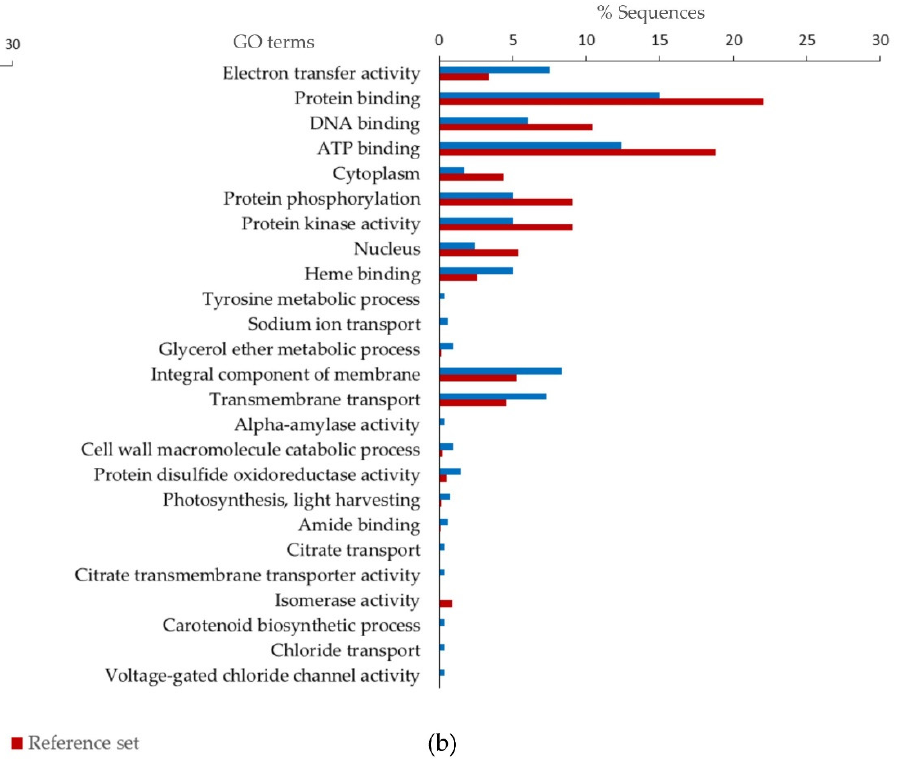
Figure 8. Fisher’s exact test enrichment plots showing the percentage of gene sequences that were enriched in a test set (up- or downregulated genes) against a reference set (annotated list of P. vulgaris genes retrieved from P. vulgaris _442_v2.1 genome). Genes that were upregulated in the slow-cooking bean (Pinto) represented the test set in ( a ), while the downregulated genes represented the test set in ( b ). DEGs with a log2 fold change of < − 1 and >1 were selected for this analysis. The GO terms were ranked in order of most significantly to least significantly enriched sequences ( p < 0.05).